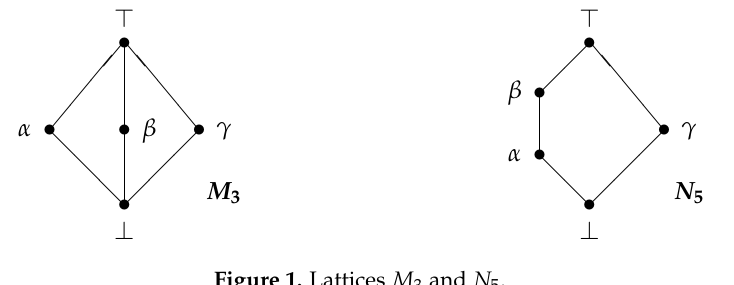
Figure 1. Lattices M 3 and N 5